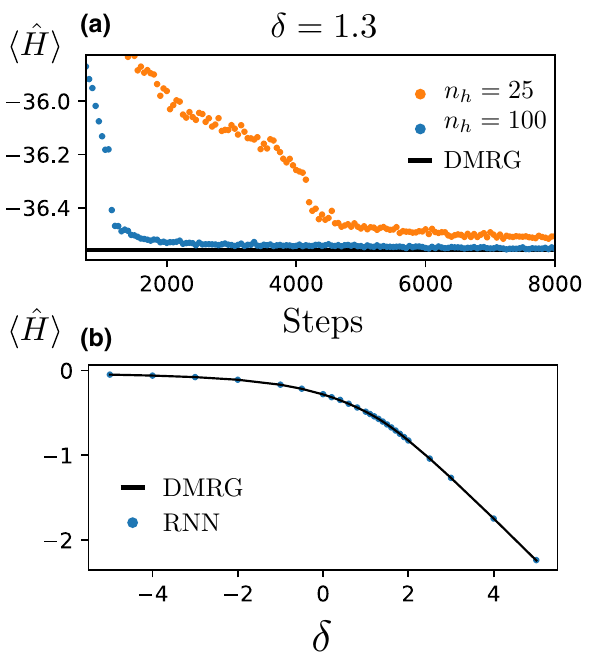
FIG. 7. Variational Monte Carlo simulation of the Rydberg Hamiltonian. (a) Average energy as a function of the training step near the phase transition at δ = 1.3. We show RNN wave func- tions with n h = 25 and n h = 100 hidden units, compared with the result obtained from DMRG. The first few VMC iterations are not plotted to increase readability of the convergence tran- sient. (b) Average energy over the full phase diagram for a RNN wave function with n h = 100, in comparison with